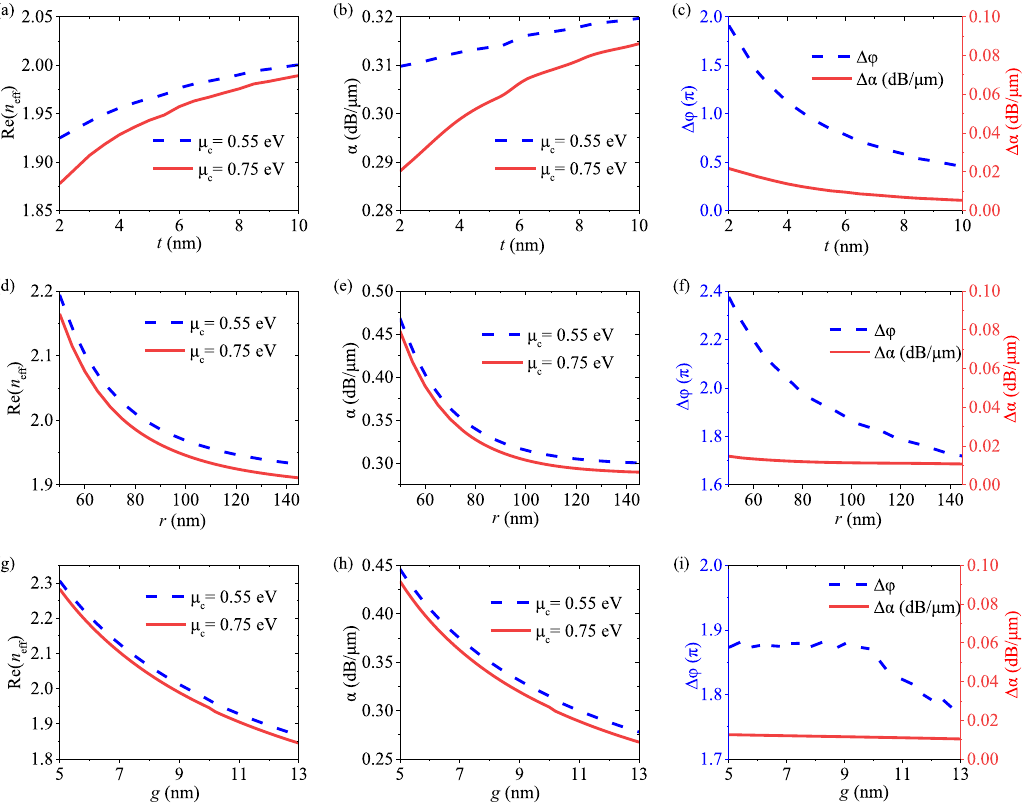
Figure7: (a) – (c)DependenceofRe( n eff ), α , Δ φ and Δ α onthickness t rangingfrom2to10 nmwith r =100nmand g =10nm.(d) – (f) Thickness t rangingfrom2to10nmtheradius r rangingfrom50to145nmwith g =10nmand t =5nm.(g) – (i)Gap g rangingfrom5to13nmwith r =100nm and t = 5 nm under different μ c of 0.55 and 0.75 eV at 1.55 μ m,